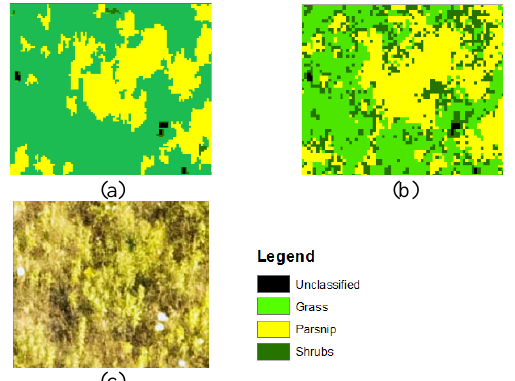
Figure 5 . The Comparison between (a) object-based and (b) pixel-based classification result with (c) UAV